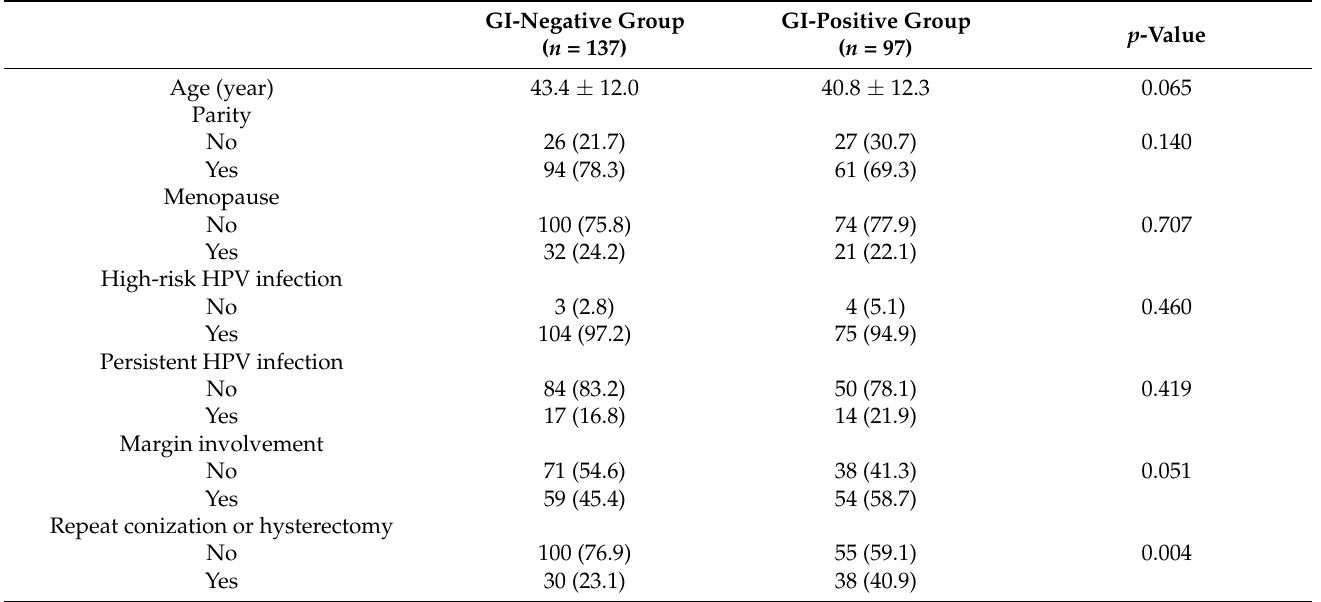
Table 2. Comparison of clinical factors and treatment outcomes between glandular involvement (GI)-negative and GI-positive patients.